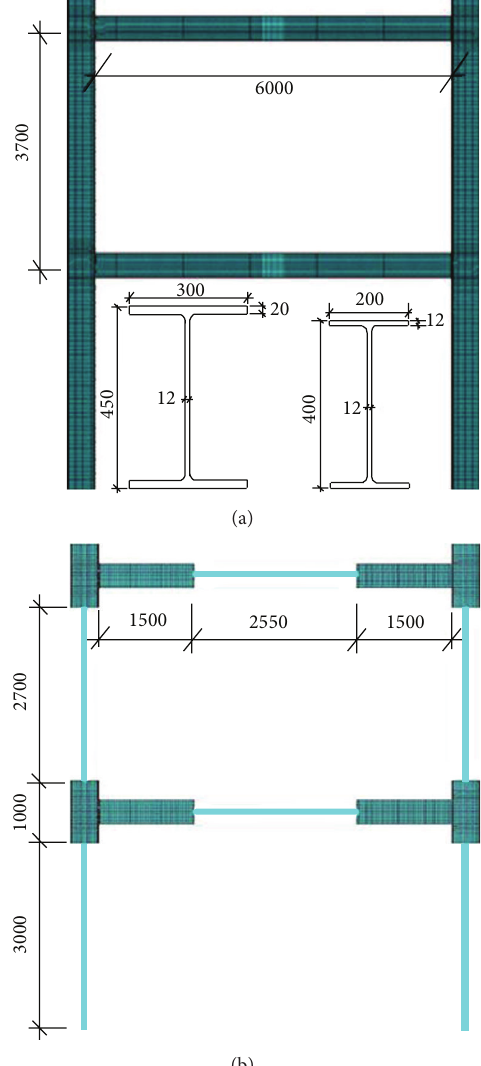
Figure 18: (a) All solids models and section size and (b) multiscale models and section